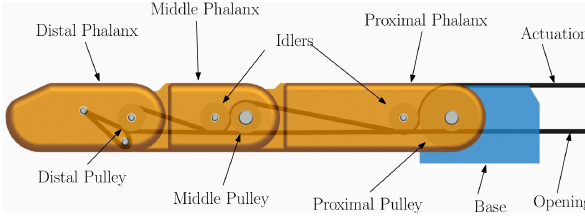
Figure 3. CAD model of the proposed finger with the actuation routing using an idler on the middle phalanx.